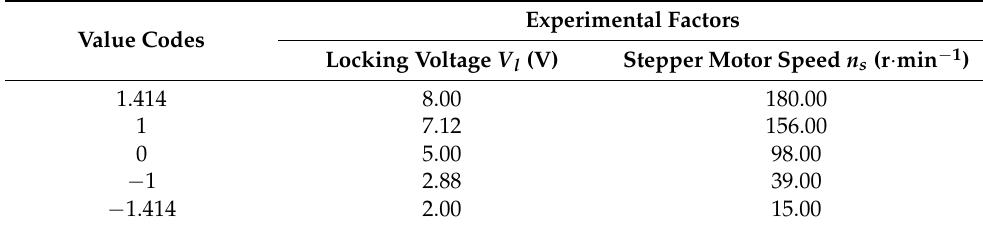
Table 1. Experimental factors and level